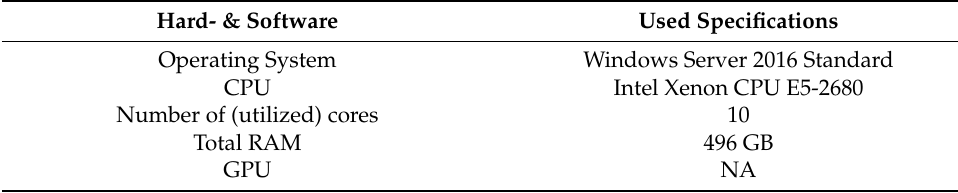
Table A2. System information of the simulation framework.